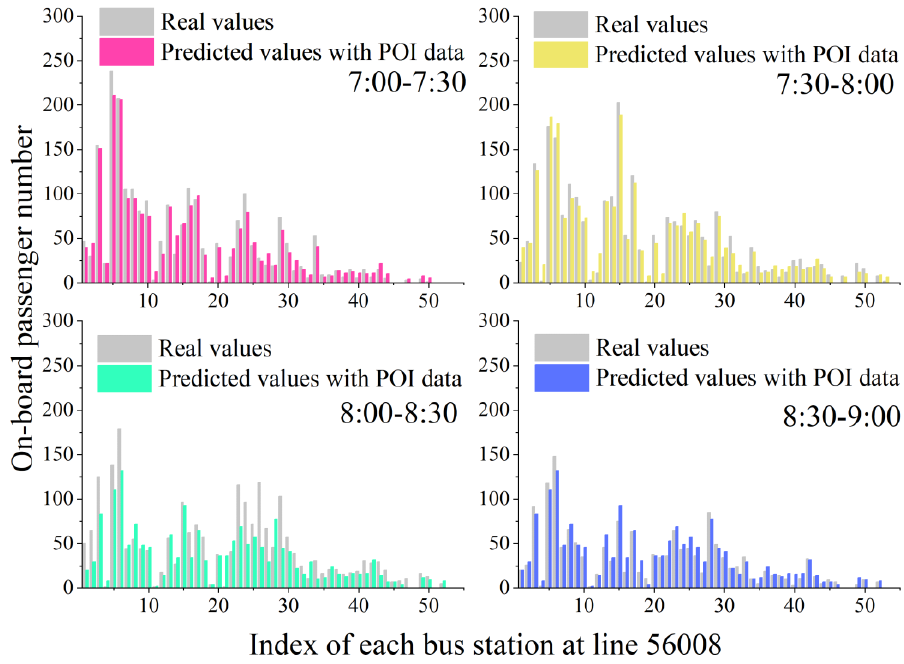
Figure 3. Prediction and true values of on-board passenger number for line 56008.